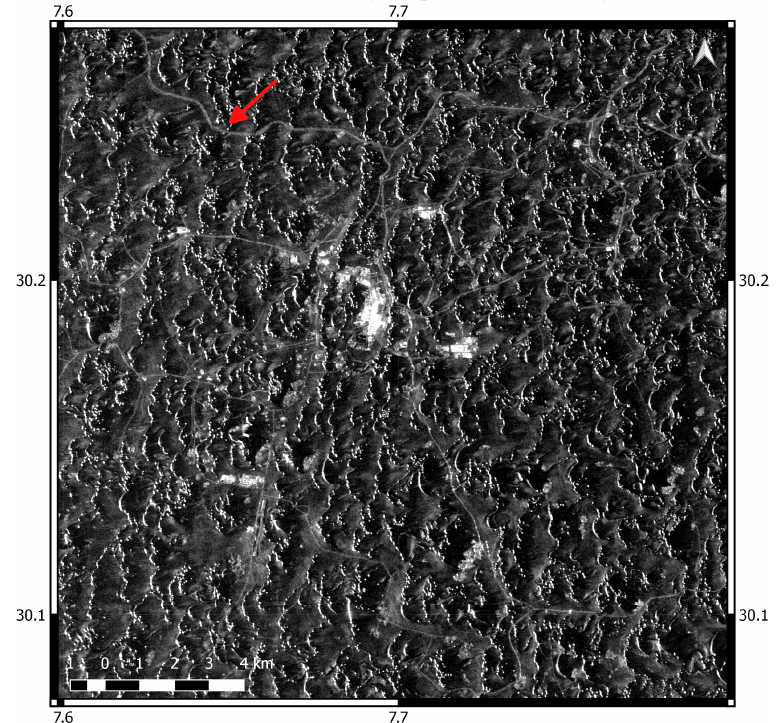
Figure 13. The Sentinel–1 average VV backscatter used as an input to the model for the Grand Erg Oriental. The area is the same as that of Figure 12. Contains modified Copernicus Sentinel–1 data 2020.